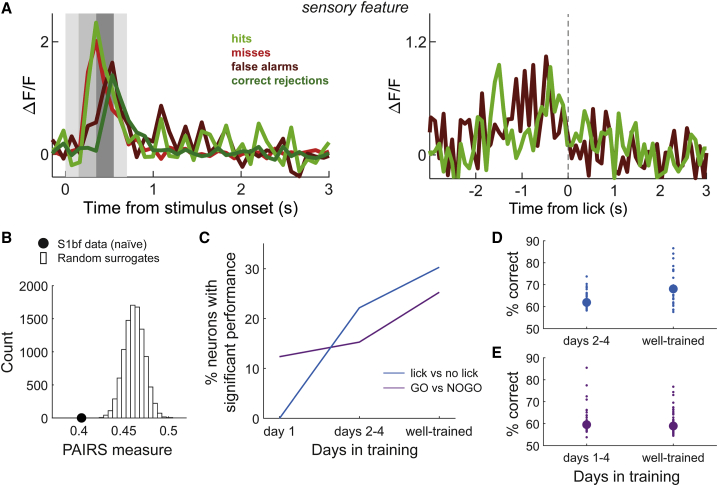
Progression of Neuronal Selectivity to Sequence Identity and the Associated Actions over the Course of Training(A) Example neuron selective to a specific sensory feature. Left, mean ΔF/F0 relative to stimulation time. Striped background demarcates segments in the stimulus sequence. Note how the neuron responded later on NOGO trials (FA and CR) than on GO trials (hits and misses), indicating sensitivity to sensory features present at different times depending on trial type and regardless of the animal’s action (hit and miss responses were similar to each other, and so were FAs and CRs). Right, mean ΔF/F0 relative to first lick (dashed line). The neuron’s average response was not time locked to licking.(B) Median PAIRS value (index of response similarity) for naive S1bf data compared to distribution for 10,000 random surrogates.(C) Progression of the percentage of neurons with significant performance with days in training. Progression is significant for both curves: for GO versus NOGO classification, χ2 statistic = 11.36, p = 0.0034, χ2 test. For lick versus no-lick, χ2 statistic = 9.97, p = 0.0068, χ2 test.(D) Classification performance for significant neurons on lick versus no-lick for different stages of training. Small dots: individual neurons. Thick dot: median.(E) Classification performance for significant neurons on GO versus NOGO for different stages of training. Small dots: individual neurons. Thick dot: median.